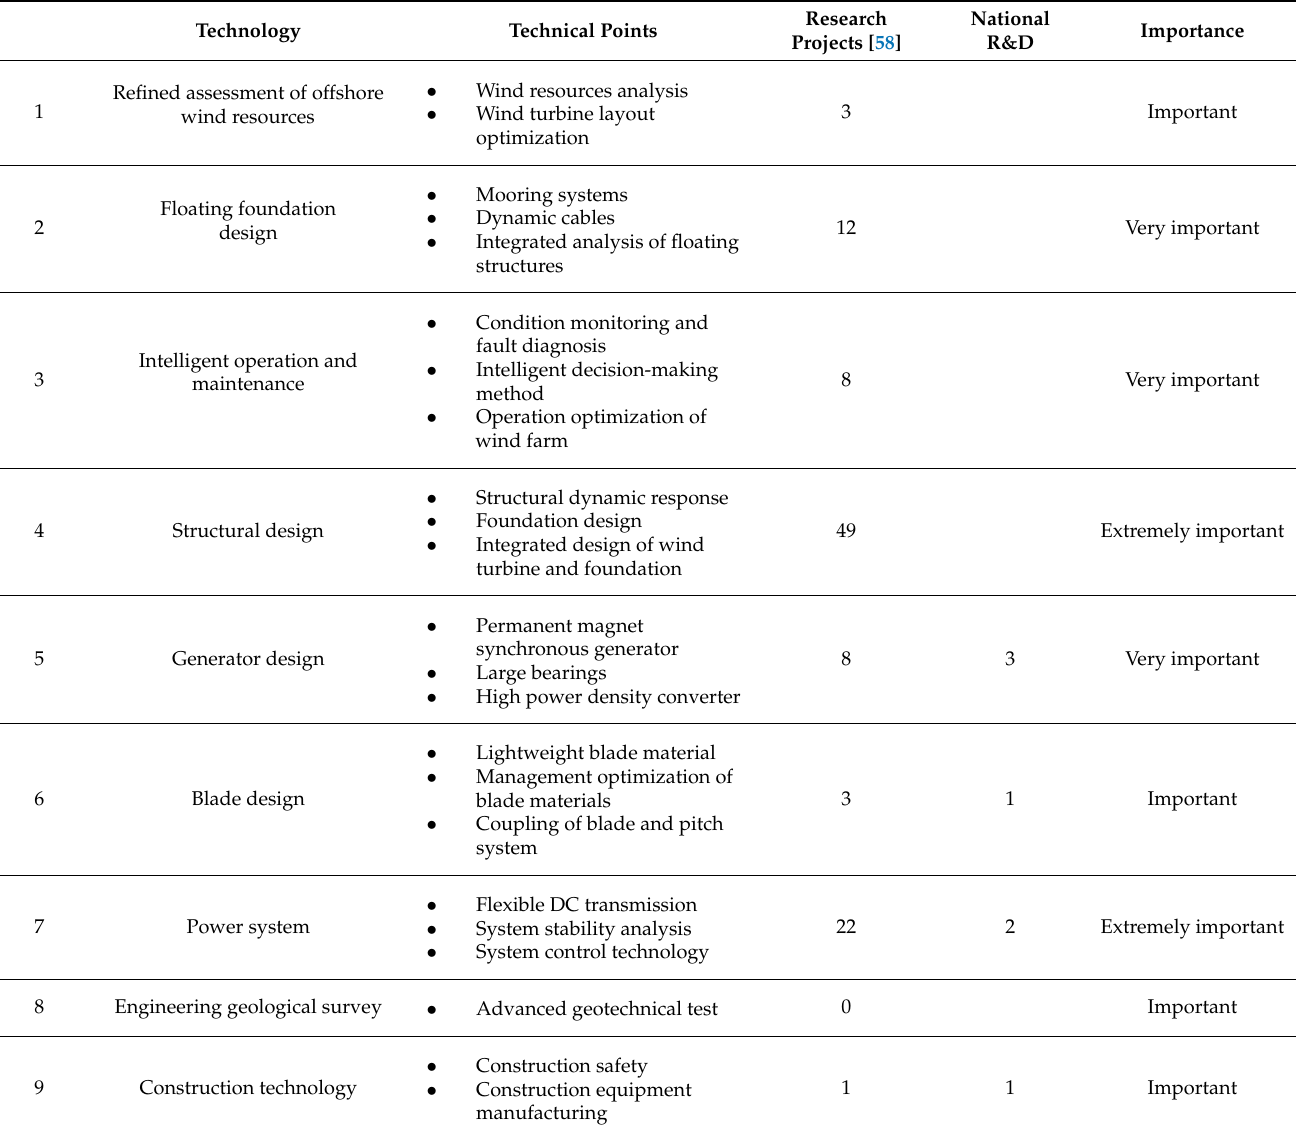
Table 2. Key technologies for wind power developed in China from 2010 to